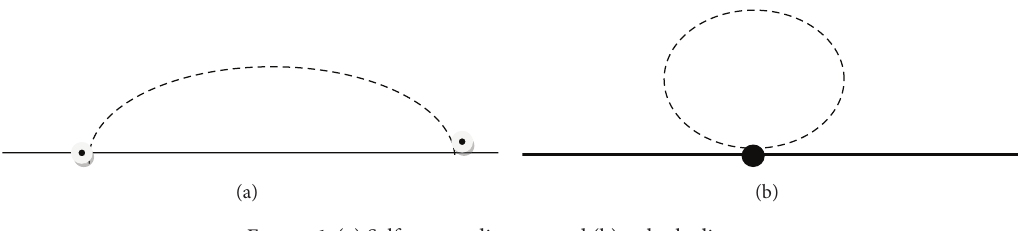
Figure 1: (a) Self-energy diagram and (b) tadpole diagram. Table 1: Self-energy of a nucleon, 𝛿𝑚 𝑁 , arising due to its interactions with the topological charge density in monopole, dipole, exponential, and sharp cutoff schemes as a function of regulator scale Λ . 𝜂 - 𝜂 󸀠 mixing angle 𝜃 is taken as − 18.5 ∘ . In dipole and exponential regularizations, in the tadpole diagram the form factor 𝑢 (which appears at each vertex in the self-energy diagram), 𝑢 3/2 or 𝑢 2 , has been used. Numerical values of Λ and 𝛿𝑚 𝑁 are in GeV